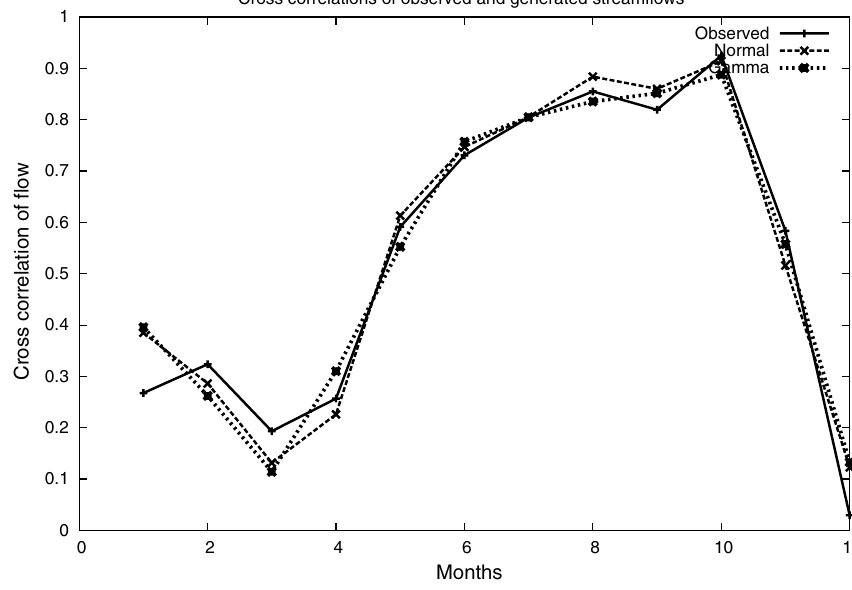
Cross correlations of observed and generated streamflows"